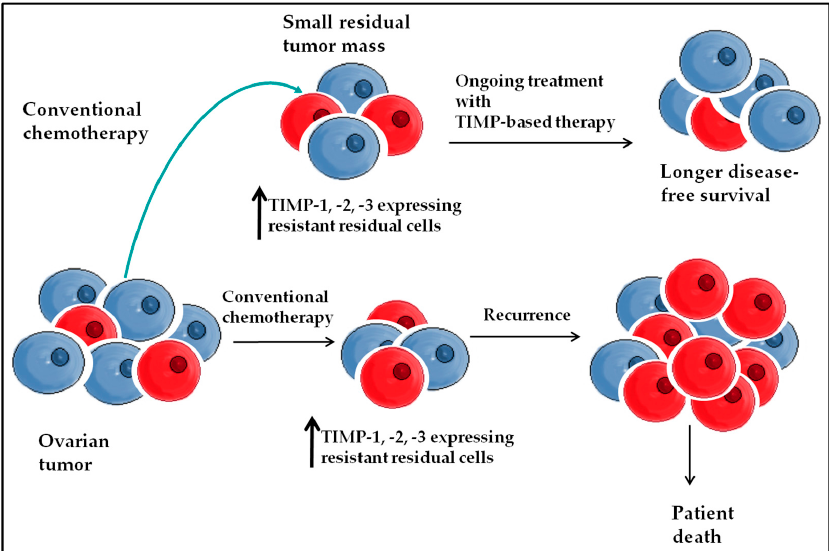
Figure 5. Proposed model of achieving a longer remission period with TIMP-based therapy in ovarian cancer. Current treatment of ovarian tumors after surgery with conventional chemotherapy results in smaller residual tumors containing chemoresistant cells. The surviving chemoresistant cells are able to proliferate; and subsequently develop recurrent tumors which lead to disease relapse and death in ovarian cancer patients. The addition of TIMP-based therapy may suppress TIMP expression in chemoresistant cells, which may suppress the growth of chemoresistant cells, thus impeding their tumorigenic potential, thus prolonging the overall remission period in ovarian cancer patients.